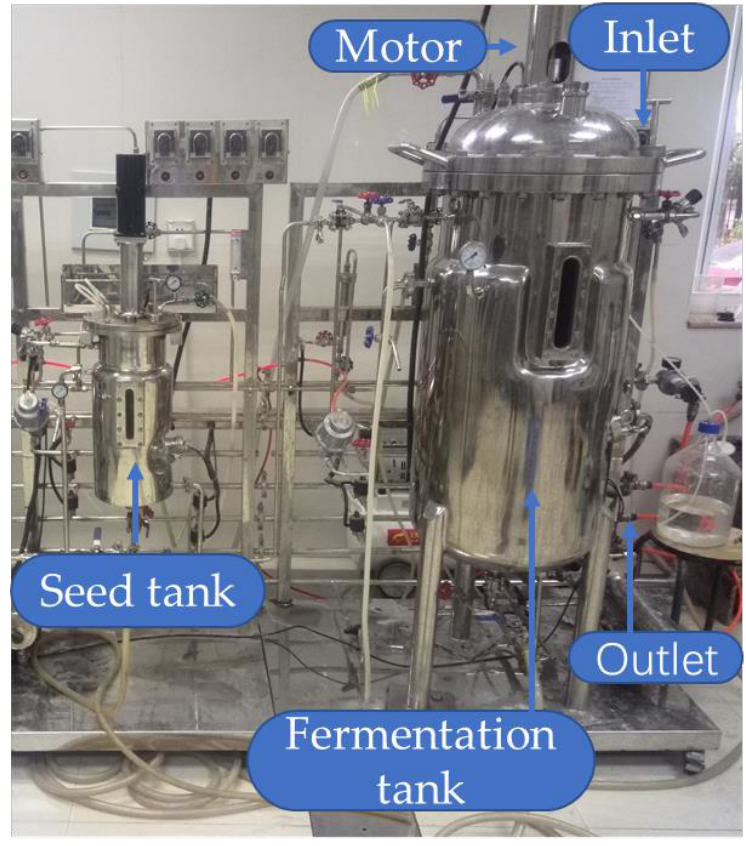
Figure 8. Pilot-scale experimental set-up (100 L).